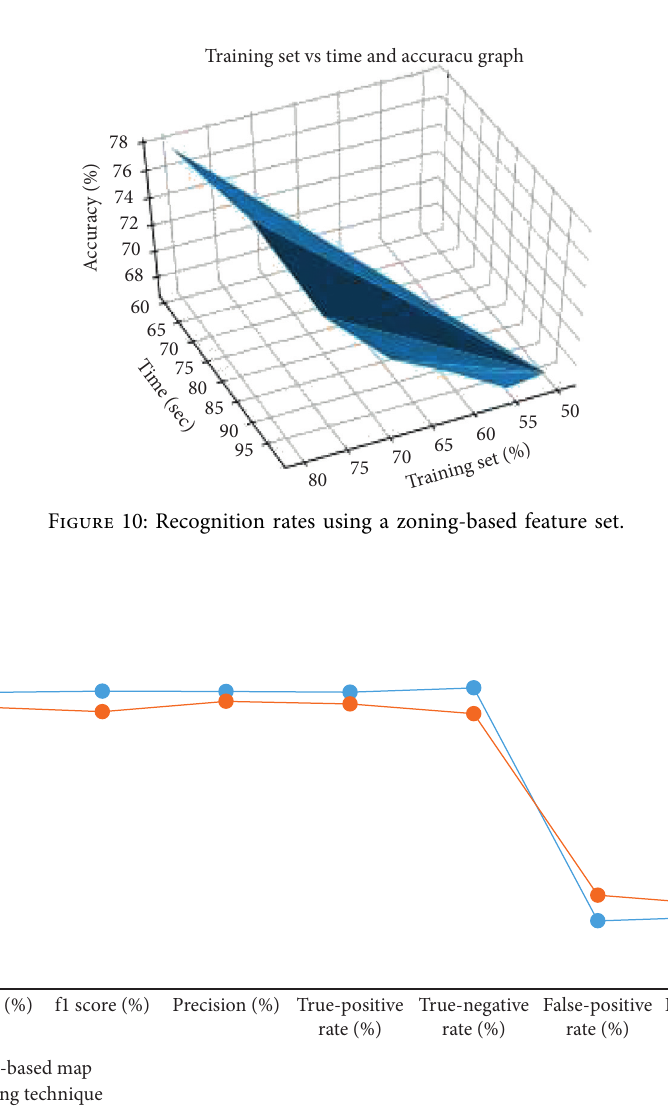
Figure 11: OCR results based on different performance